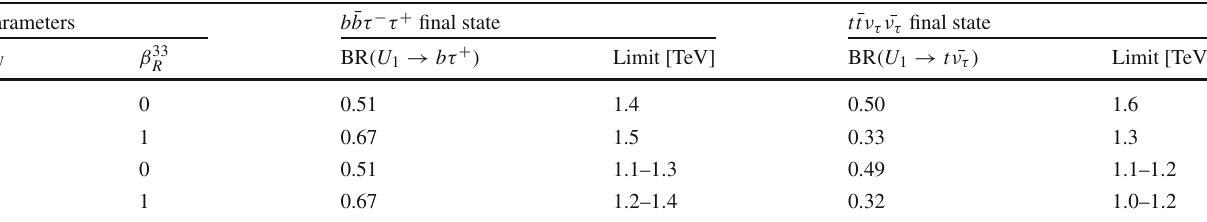
Table 2 Summary of the experimental constraints on pair produced leptoquarks in the b ¯ b τ − τ + [41] and t ¯ t ν τ ¯ ν τ [42] final states, assuming the leptoquarks decay solely into third generation SM particles. When